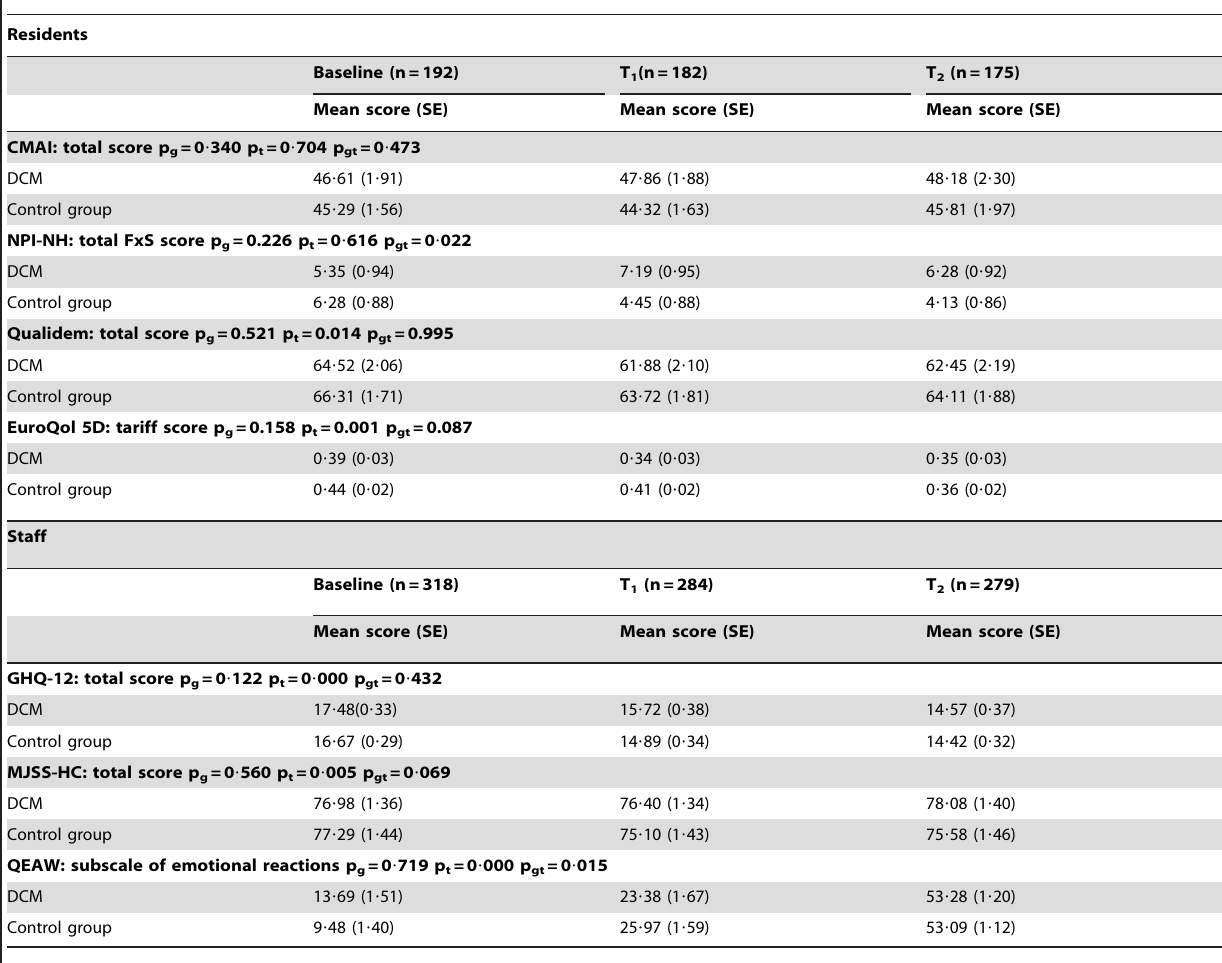
Table 2. Effects of dementia-care mapping on residents and staff based on intention-to-treat analysis.